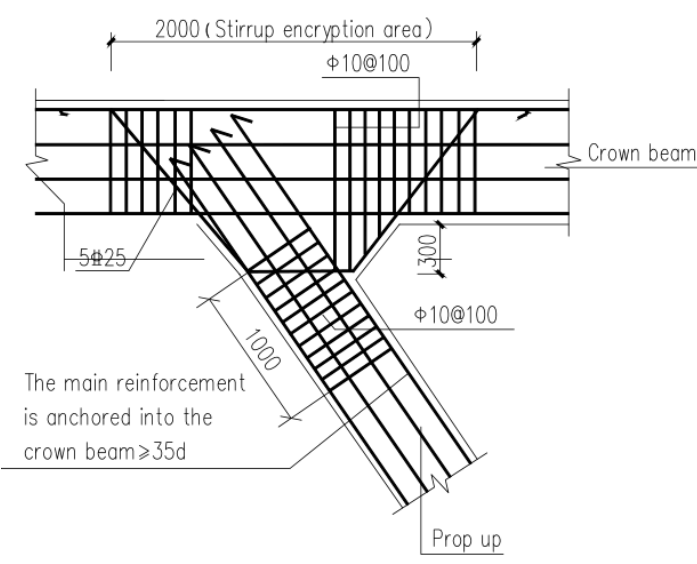
Figure 5. Construction drawings of angular braces/diagonal braces and crown joints.